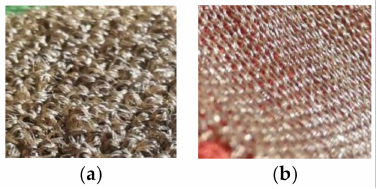
Figure 13. ( a ) Close-up of electrode version with an uneven surface (E4). ( b ) Close-up of electrode version with a smooth surface (E1).